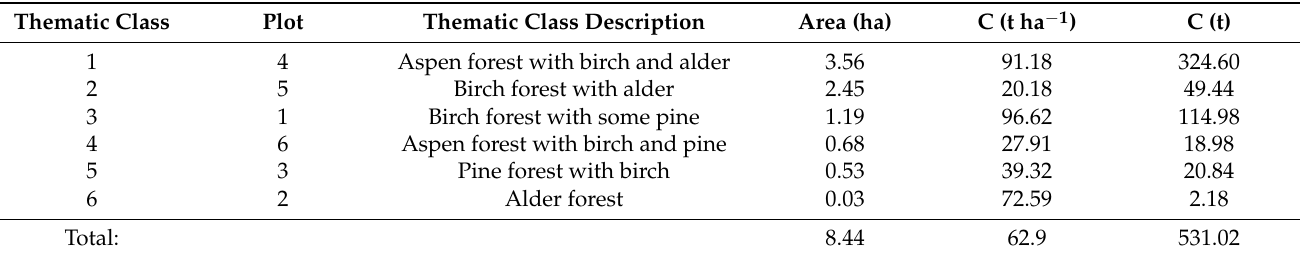
Table 1. Characteristics of forest thematic classes and aboveground carbon losses as a result of tree stand and understorey death after fire. Non-forest classes were not included in the